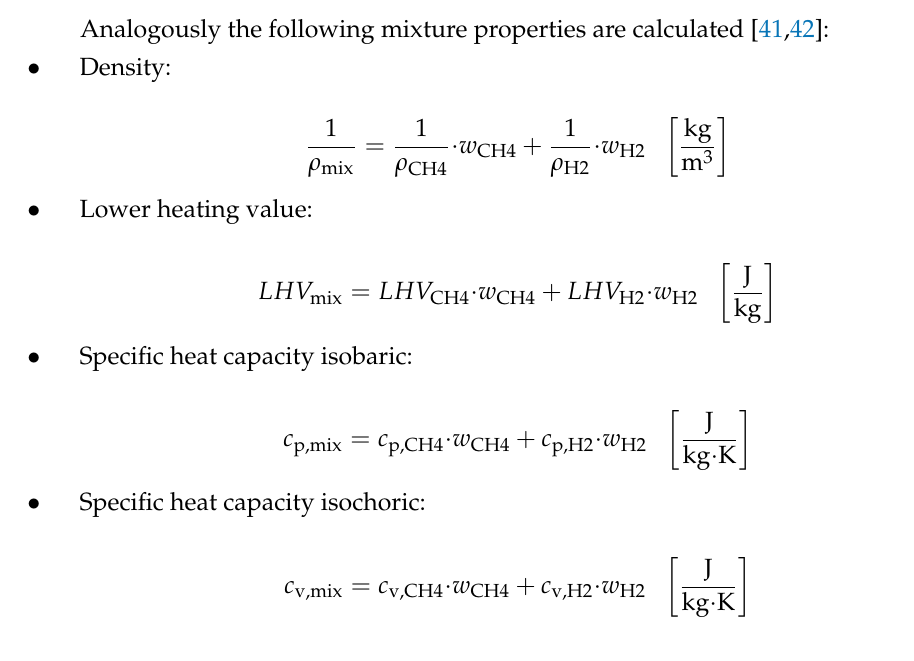
Figure 1. Iterative calculation of the friction factor λ.